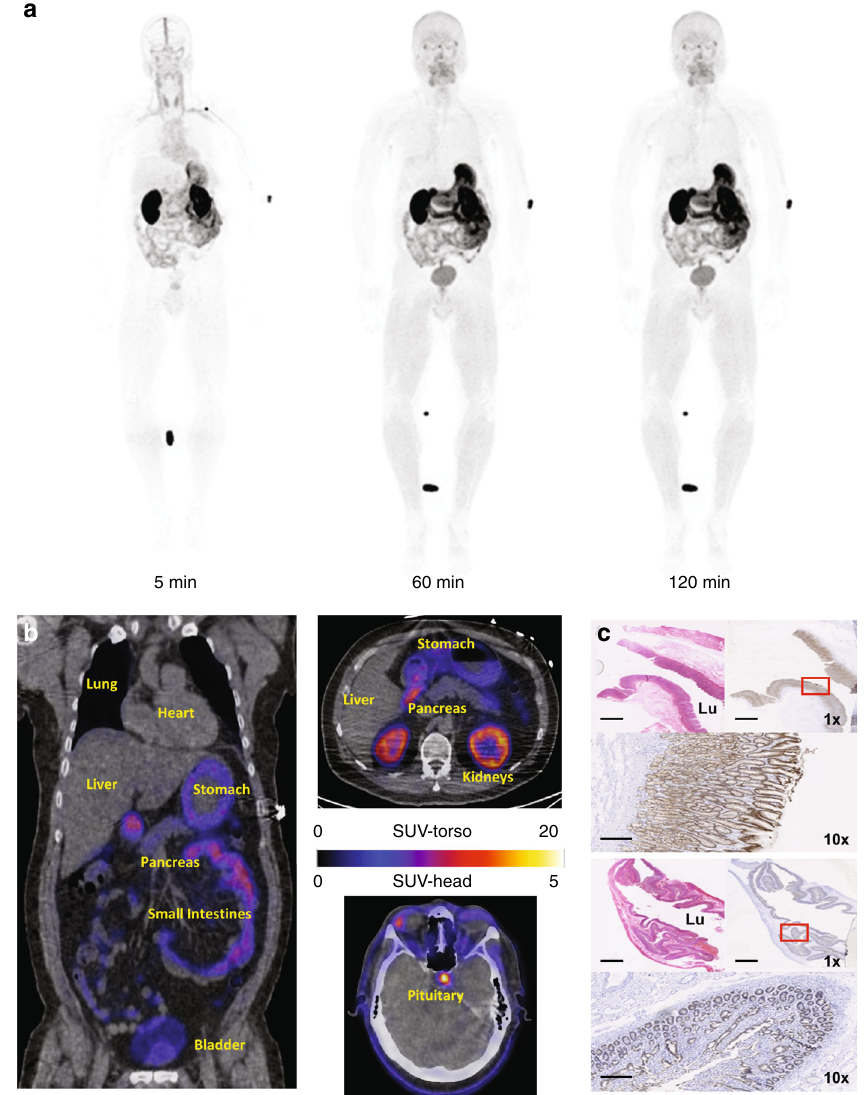
Fig. 2 [ 18 F]FP-R 0 1-MG-F2 PET imaging of fi ve healthy human volunteers. a Representative whole-body [ 18 F]FP-R 0 1-MG-F2 maximum intensity projection (MIP) PET images of a healthy volunteer (50-year-old male) show the biodistribution of PET tracer at ~ 5, 60, and 120 min post injection (p.i.). Focal uptake near the elbow and between the legs are the site of intravenous injection, and a tube containing the reference calibration standard, respectively. b Axial and coronal PET/CT images of the same healthy volunteer at 1 h p.i. Close-ups of the chest and abdominal regions show the heart (SUV mean ~ 0.9), liver (SUV mean ~ 0.8), lung (SUV mean ~ 1.3), pancreas (SUV mean ~ 1.9), stomach (SUV mean ~ 12.6), small intestines (SUV mean ~ 7.8), kidneys (SUV mean ~ 14.3), and bladder (5.9). Accumulation of the tracer is evident in the pituitary gland (SUV mean ~ 5). c H&E staining (top left) and integrin α v β 6 (top right and bottom) immunohistochemical analysis of healthy stomach and small bowel tissue, where uptake was relatively high (Supplementary Table 7, below), shows expression of integrin α v β 6 on the luminal (Lu) side of these organs. Scale bars on the 1x and 10x images represent 2.5 cm and 250 mm, the liver exhibited SUV mean s of 0.9 and 2.9, respectively, at 1 h p.i. SUV mean s of [ 18 F]FP-R 0 1-MG-F2 in the stomach and small intestines were 22.9 and 10.7, respectively, at 1 h p.i. In comparison, SUV mean s of [ 18 F]FDG in the stomach and small intestine at 1 h p.i. were 0.16 and 2.5, respectively. IHC analysis of